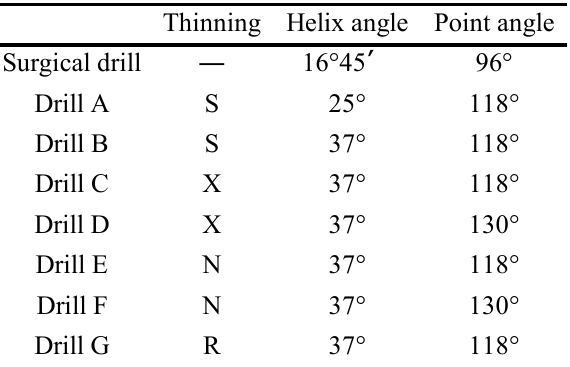
Table 1 Details of the eight experimental drills